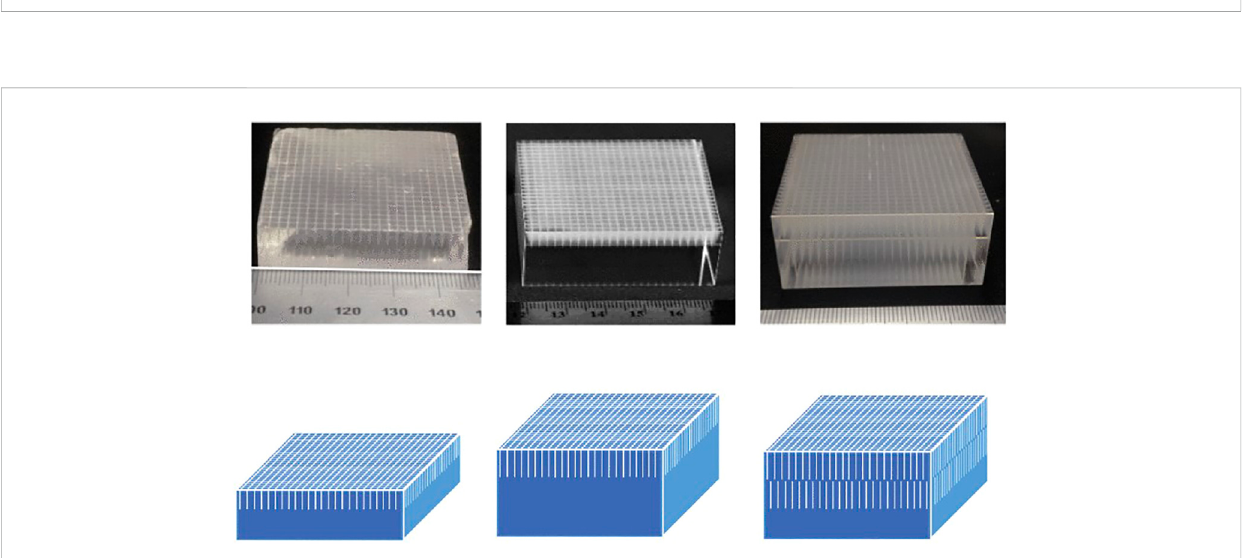
FIGURE 7 Example of single and double set LIOBs on LYSO scintillators of various thicknesses on 50 mm 2 cross-section crystals. Top images are etched crystals, bottom images are schematics of the LIOB, etch patterns. A scintillator 14 mm thick with a single layer of LIOB 5 mm long (Left). A